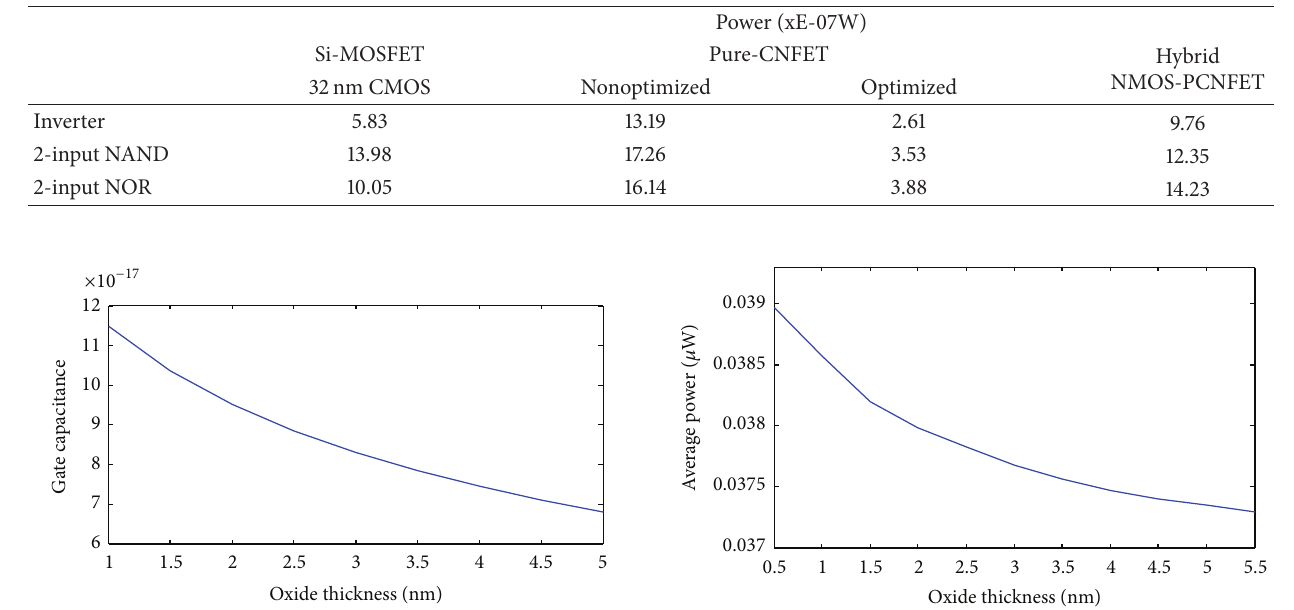
Table 5: The power dissipation of inverter, 2-input NAND, and 2-input NOR gates for Si-MOS, pure-CNFET, and hybrid configuration.